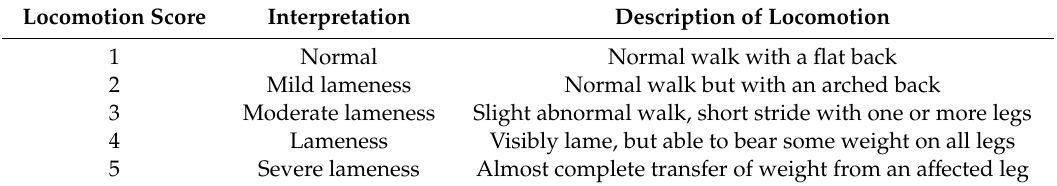
Table 1. Lameness Scoring System used in the study to determine the prevalence of lameness a . Locomotion Score Interpretation Description of Locomotion 1 Normal Normal walk with a flat back 2 Mild lameness Normal walk but with an arched back 3 Moderate lameness Slight abnormal walk, short stride with one or more legs 4 Lameness Visibly lame, but able to bear some weight on all legs 5 Severe lameness Almost complete transfer of weight from an a ff ected leg a Adopted from Sprecher et al.